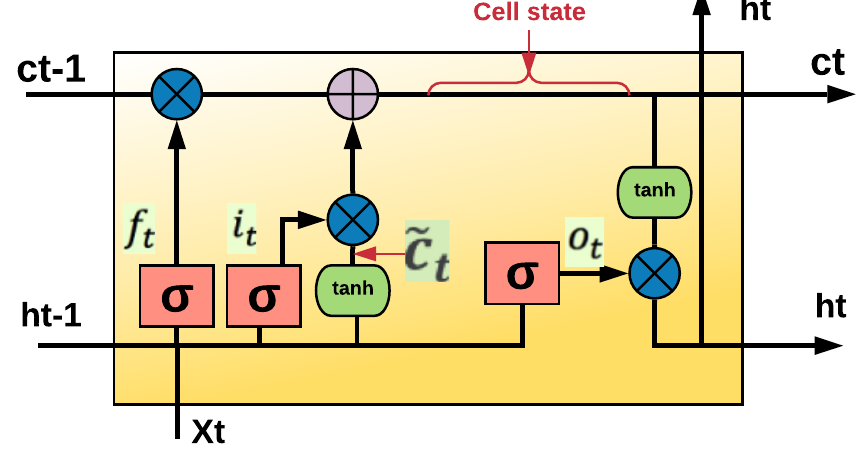
Figure 1. Single long short-term memory (LSTM)